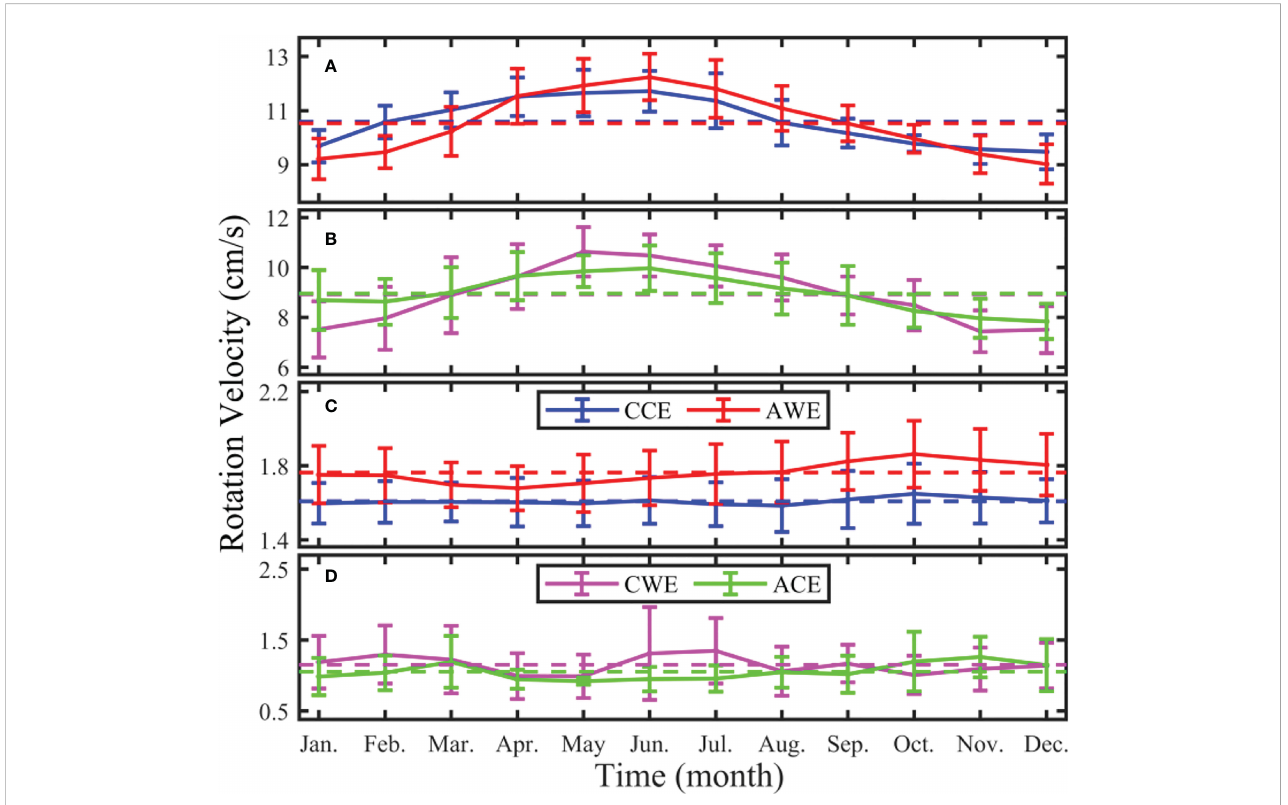
FIGURE 3 Monthly distribution of multi-year (2008 ~ 2017) average eddy rotation velocity at the sea surface (A, B) and 1,000 m (C, D) in the STCC area. Blue, red, pink, and green curves represent cyclonic cold-core eddy, anticyclonic warm-core eddy, cyclonic warm-core eddy, and anticyclonic cold-core eddy, respectively. The bar line represents the standard deviation, and the dotted line represents the multi-year average